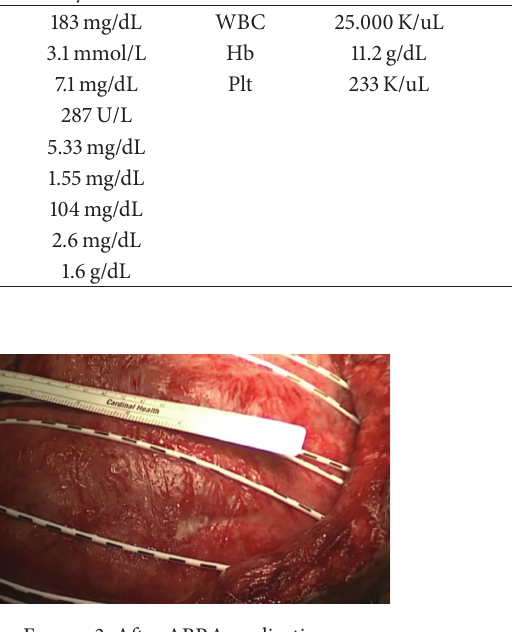
Figure 3: After ABRA application.